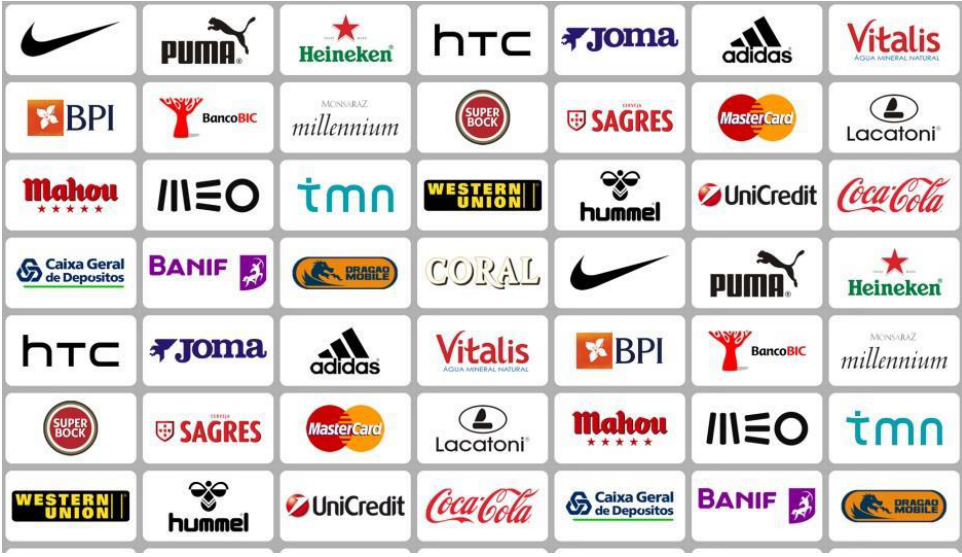
Figure 1. Marks placed in the experiments with up to 50 logos.